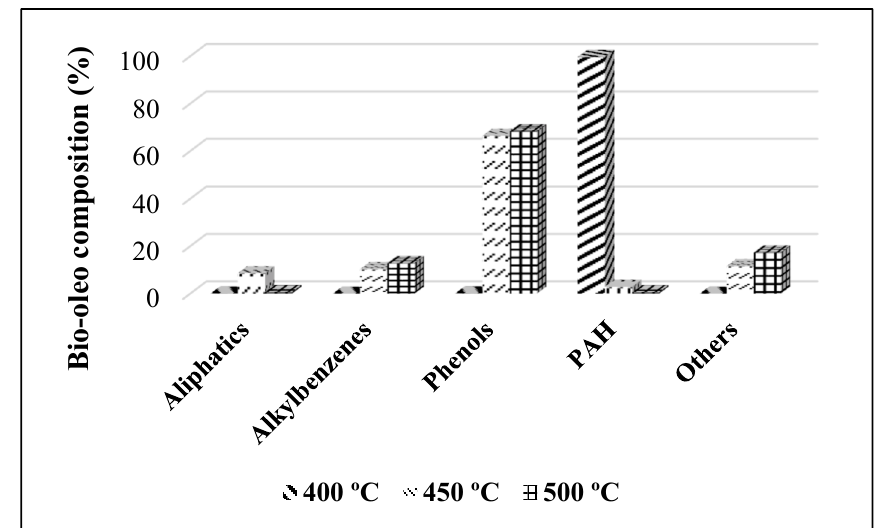
Figure 7. Influence of the reaction temperature on the bio-oil products composition of SCWG of eucalyptus wood chips at 400, 450, and 500 °C, using 2 g of NiFe 2 O 4 catalyst and 60 min.